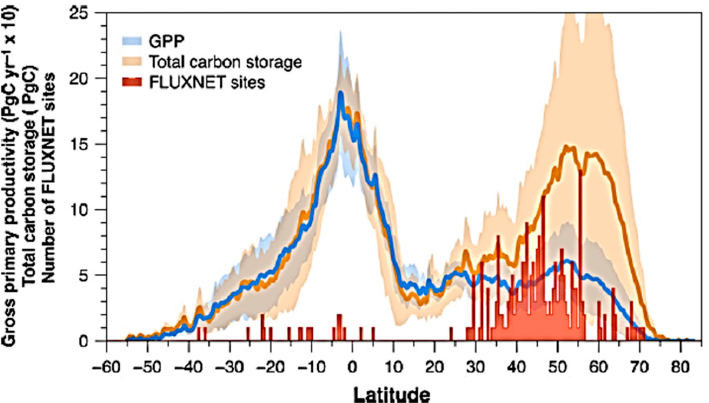
Figure 1. The distribution of gross primary production and total carbon storage as a function of latitude (copyright [3]).